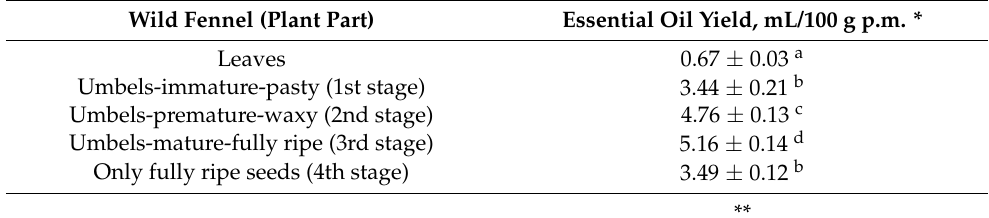
Table 1. Yield of essential oil from the fennel leaves, umbels (1st–3rd stage) and seeds obtained after 120 min of hydrodistillation (hydromodulus 1:10 m / v